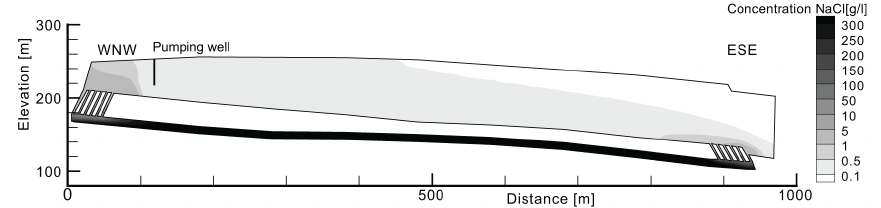
Figure 9. Simulated NaCl Concentration (with 6 each of 15m wide faults) after 3years.